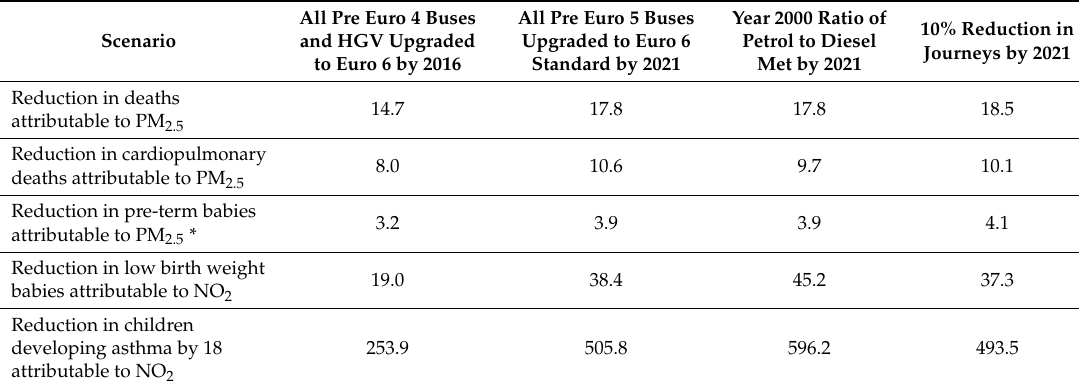
Table 2. Estimated annual reduction in all deaths, cardiopulmonary deaths and adverse birth outcomes given various LEZ scenarios (Leeds and Bradford